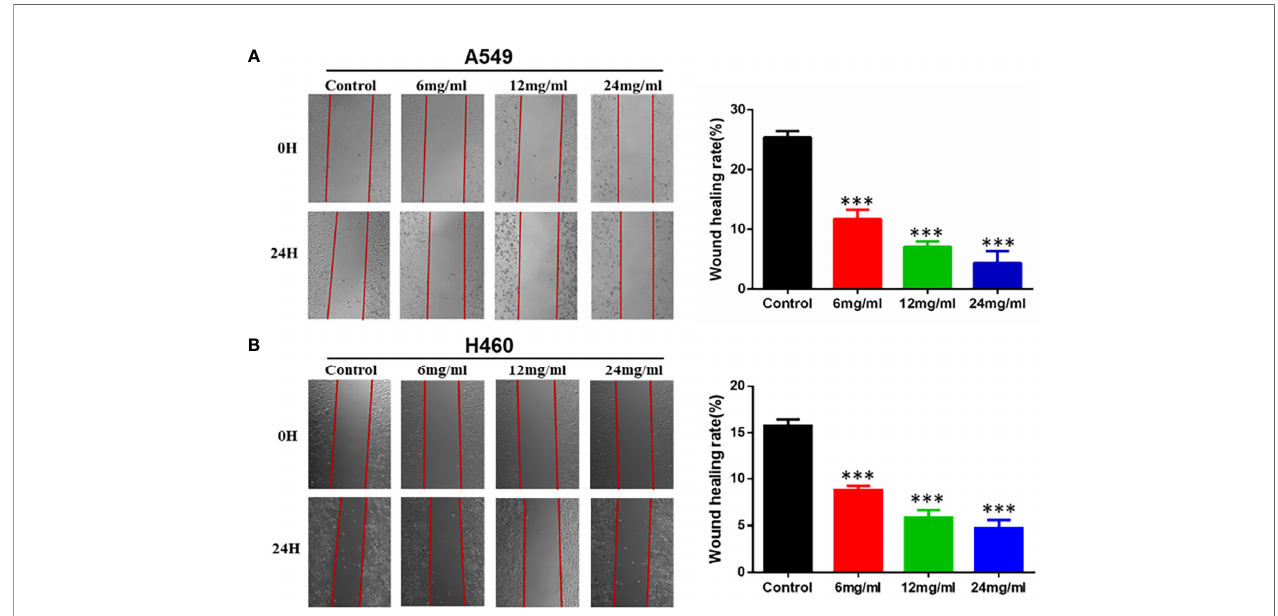
FIGURE 8 | HMMCR inhibits the migration of NSCLC cells. The migration of (A) A549 and (B) H460 cells after HMMCR treatment at the doses of 0 – 24 mg/ml for 24 h were determined by wound healing assay and quanti fi ed by Image J software. ***p < 0.001 vs. control.